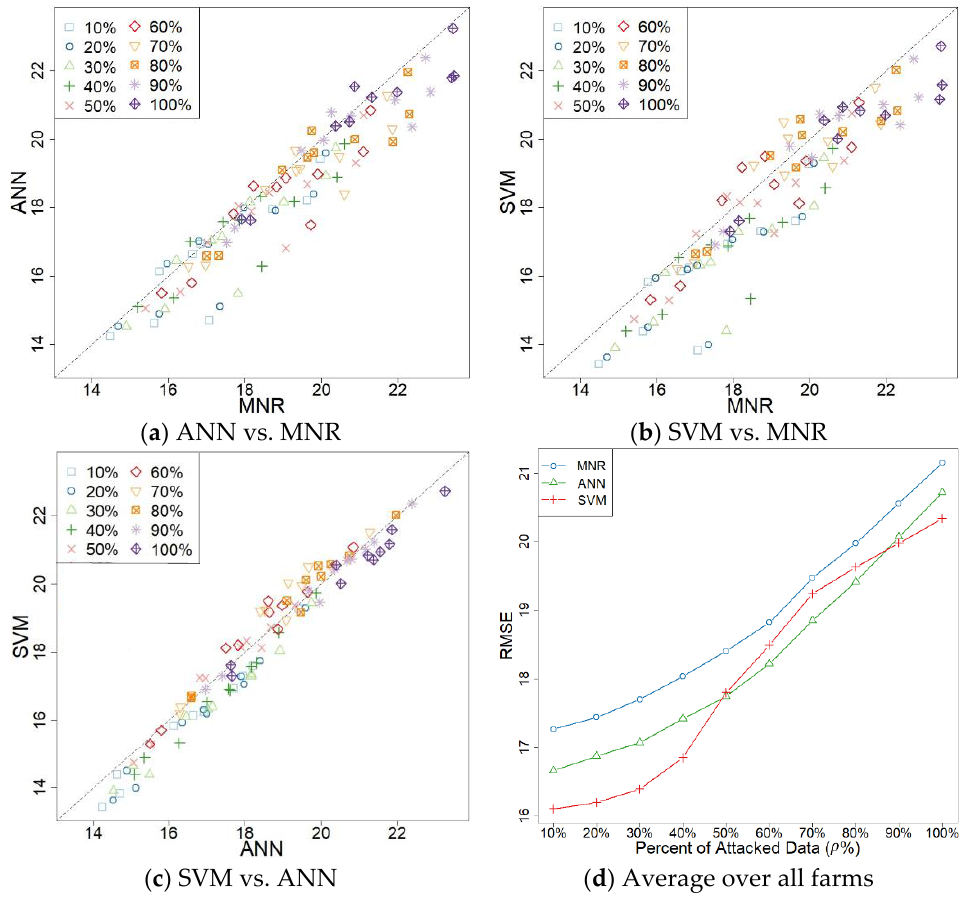
Figure 4. RMSE values of ten wind farms under various levels of false data attacks (ANN: Artificial Neural Network, MNR: Multiple Nonlinear Regression, SVM: Support Vector Machine).